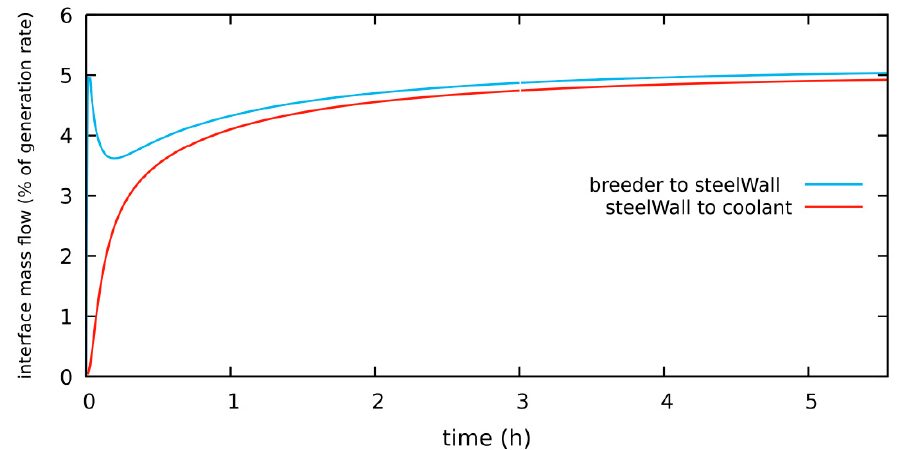
Figure 6. Transient tritium flow through patch interfaces breeder to and from steel and steel to and from coolant for single- vs. two-species model with no/1 × 10 − 3 Pa H 2 in the purge gas.